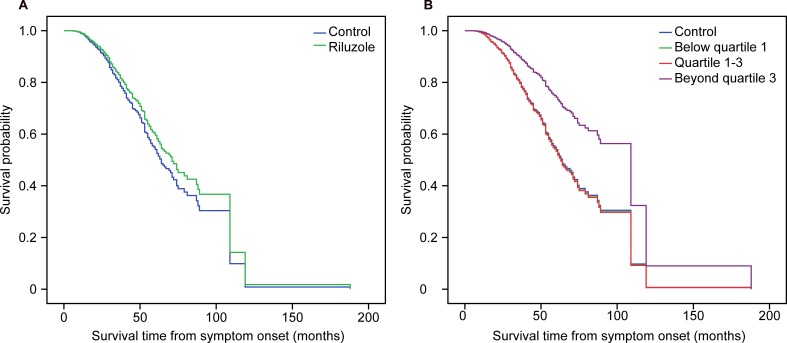
Survival curves after adjusting for age, gender, BMI, diagnostic delay time, phenotype, Airlie House category at presentation, residence, FRS score, history of smoking or alcohol abuse, contact history of harmful gas or pesticides at the covariate means using Cox regression model.
(A) Survival analysis stratified by riluzole; (B) Survival analysis stratified by quartiles of dose of riluzole.